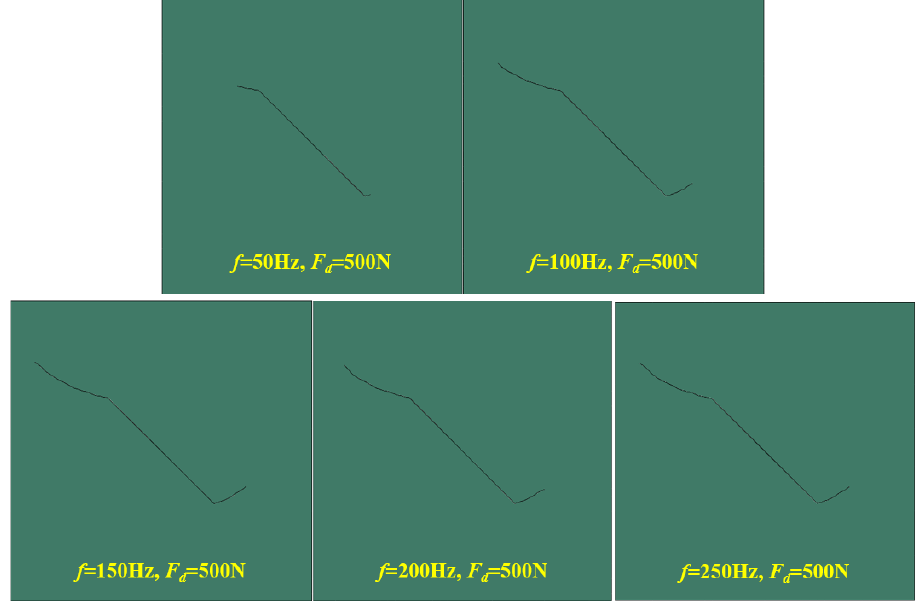
Figure 11. Schematic diagram of crack initiation under different frequencies of dynamic load.